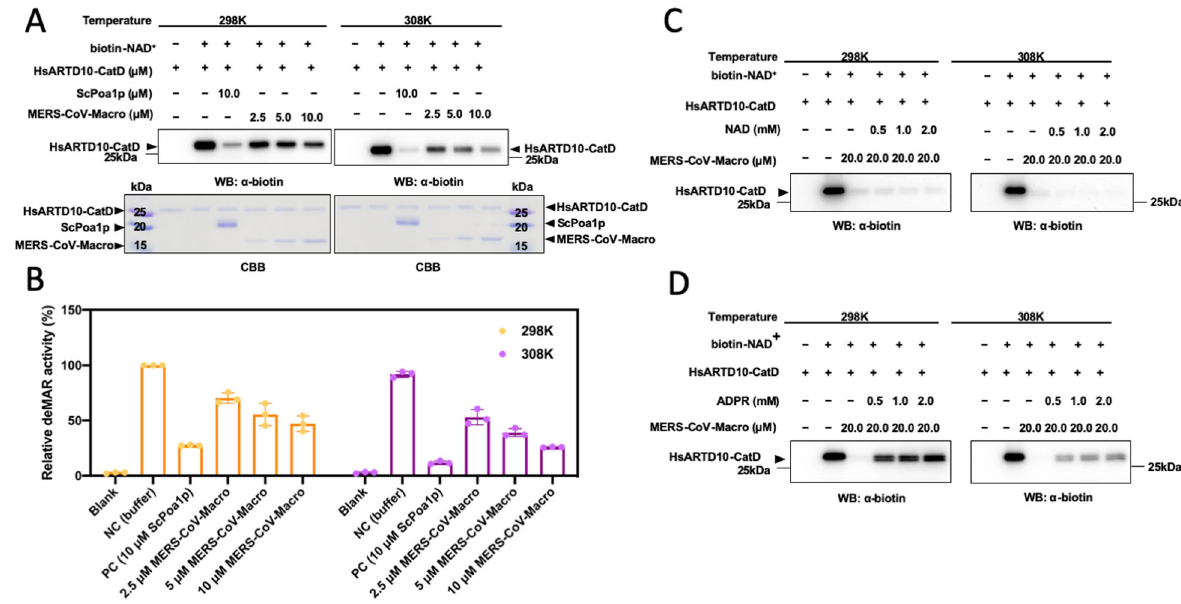
Fig. 6 De-MARylation of the MERS-CoV macro domain at different temperatures. A The deMAR enzyme activity of the MERS-CoV macro domain. Auto- mono-ADP-ribosylated human ARTD 10 catalytic domain (HsARTD10-CatD) was arranged using biotin-NAD + as a substrate. Budding yeast macro domain Poa1p (ScPoa1p) is a positive control. Varying amounts of the MERS-CoV macro domain (from 2.5 to 10.0 μ M) mixing with biotin labeled MAR- HsARTD10-CatD at 298 and 308 K were resolved by 15% acrylamide gel. The level of mono-ADP-ribosylation was detected by western blot assay using antibody anti-biotin. B The relative intensity of the bands corresponding to MAR-remained after the reactions of the MERS-CoV macro domain at different temperatures. Independent experiments n = 3. The deMAR enzyme activity of the MERS-CoV macro domain with the presence of C NAD and D ADPR, respectively. Auto-mono-ADP-ribosylated human ARTD 10 catalytic domain (HsARTD10-CatD) was arranged using biotin-NAD + as a substrate. Varying amounts of C NAD or D ADPR mixing with 20.0 μ M MERS-CoV macro domain and biotin-labeled MAR-HsARTD10-CatD at 298 K and 308 K were resolved by 15% acrylamide gel. The level of mono-ADP-ribosylation was detected by western blot assay using antibody